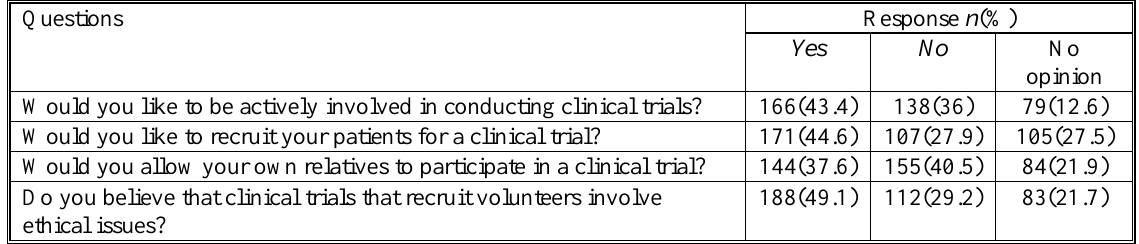
Table 6. Views of the physicians about clinical trials in Iraqi patients ( n = 383 physicians)